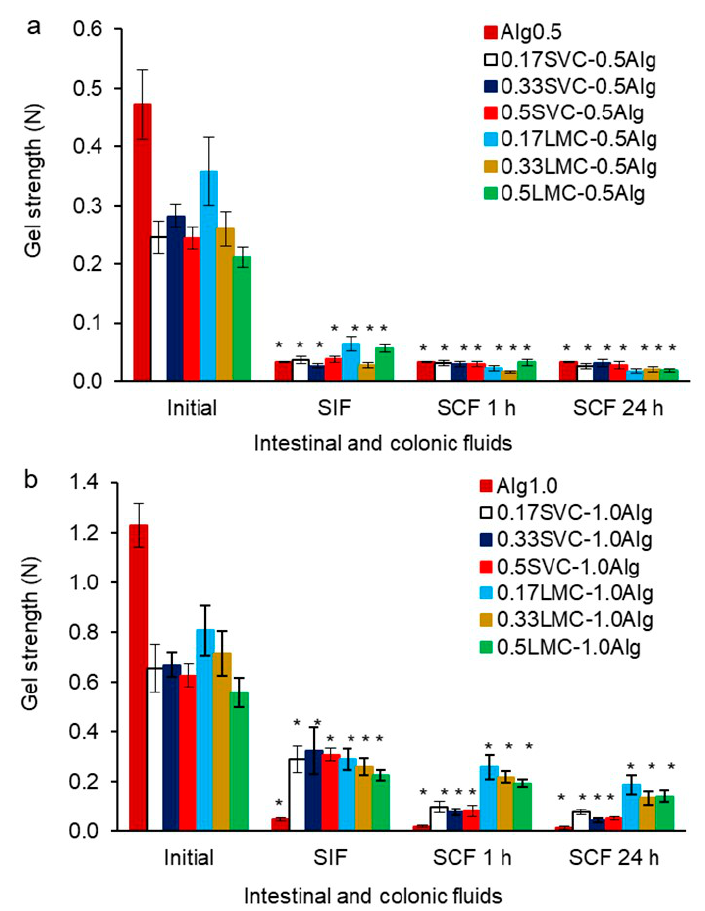
Figure 8. The gel strength of GSE-loaded hydrogels based on SVC and LMC cells and alginate at the concentration of 0.5% ( a ) and 1.0% ( b ) after successive exposure to SIF and SCF. The data are presented as the mean ± S.D., n = 15. * p < 0.05 vs. initial gel strength.